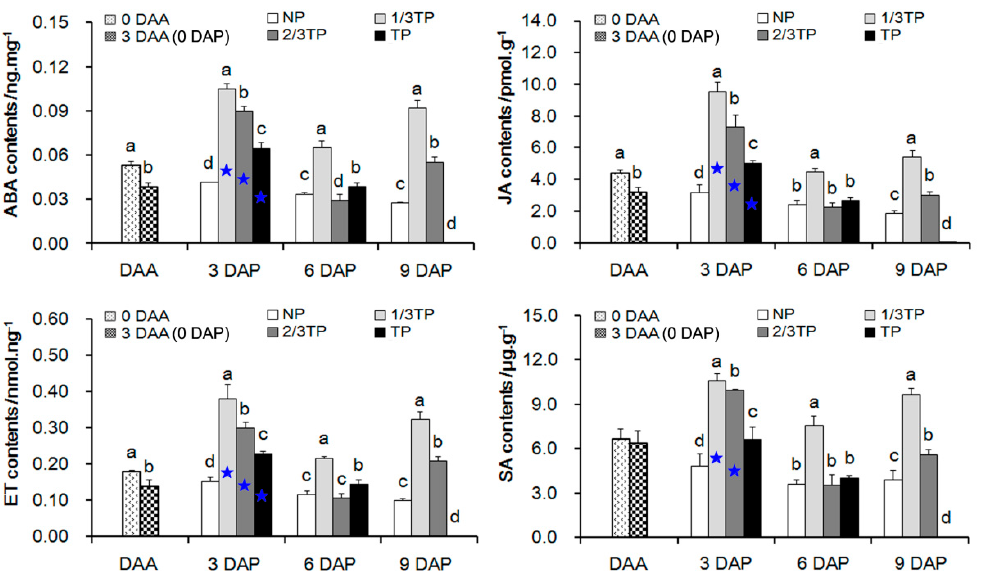
Figure 3. The four plant hormone contents in R. glutinosa roots during acclimatization stage and planting stage with di ff erent replant disease stress levels. 0 DAA, 3 DAA (0 DAP), NP, 1 / 3TP, 2 / 3TP and TP are gradient treatments. Two or four samples in each group are compared with 3 DAA (0 DAP) and NP respectively, and di ff erent lower-case letters indicate significant di ff erences ( p < 0.05; LSD). 3 DAP with NP, 1 / 3TP, 2 / 3TP and TP gradient treatments is compared with 3 DAA (0 DAP), and the asterisk indicate significant di ff erences ( p < 0.05; LSD). Data represented as the mean ± SD ( n = 3). DAA: Days after acclimatization. DAP: Days after planting. NP: Soil that was never planted with R. glutinosa for at least 10 years. TP: Soil that was consecutively planted with R. glutinosa in the same soils for three years. Table 4. Pearson correlations among the variation of the PS, FO, jasmonic acid (JA), abscisic acid (ABA), ethylene (ET) and salicylic acid (SA) contents under replant disease stresses from 0 to 3 DAP. ∆ FO ∆ JA ∆ ABA ∆ ET ∆ SA ∆ PS − 0.7327 0.1328 0.0254 0.1123 0.2366 ∆ FO − 0.6524 − 0.5981 − 0.6560 − 0.7475 * ∆ JA 0.9752 ** 0.9839 ** 0.9182 ** ∆ ABA 0.9650 ** 0.9543 ** ∆ ET 0.9009 **